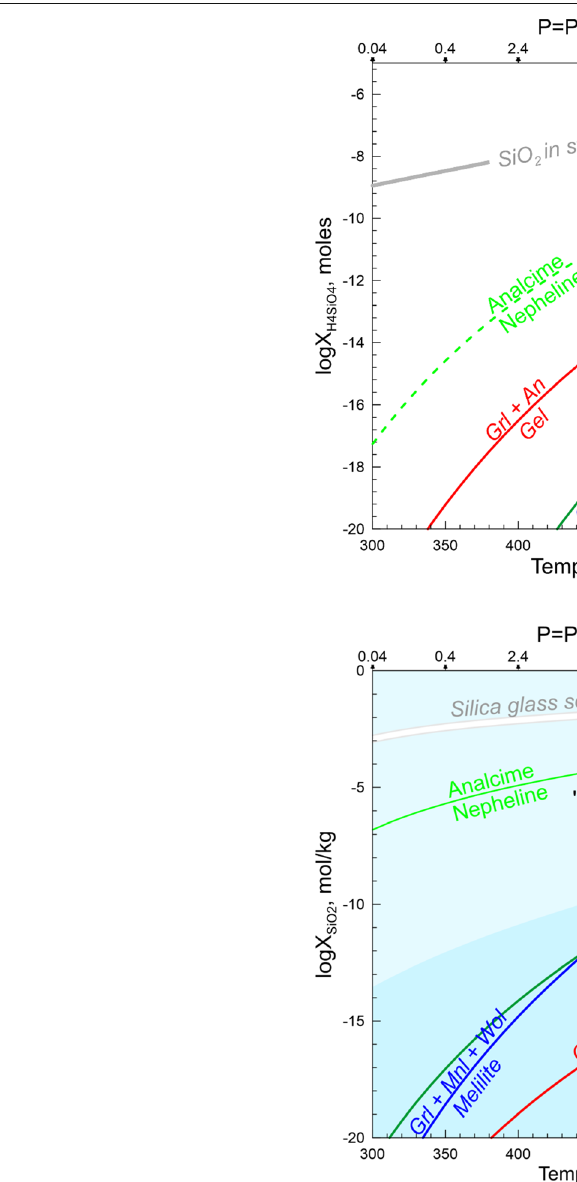
Fig. 16 Phase boundaries of reactions involving either aqueous (top panel) or gaseous (lower panel) silica. The lack of analcime among alteration products places an upper limit on X H4SiO4 or X SiO2 in steam and aqueous solution, respectively. In the lower panel, the “ condensed steam ” field designates an aqueous solution formed by in situ condensation of steam as opposed to the “ external ” aqueous solution, which comes to a CAI from outside (matrix?) as a